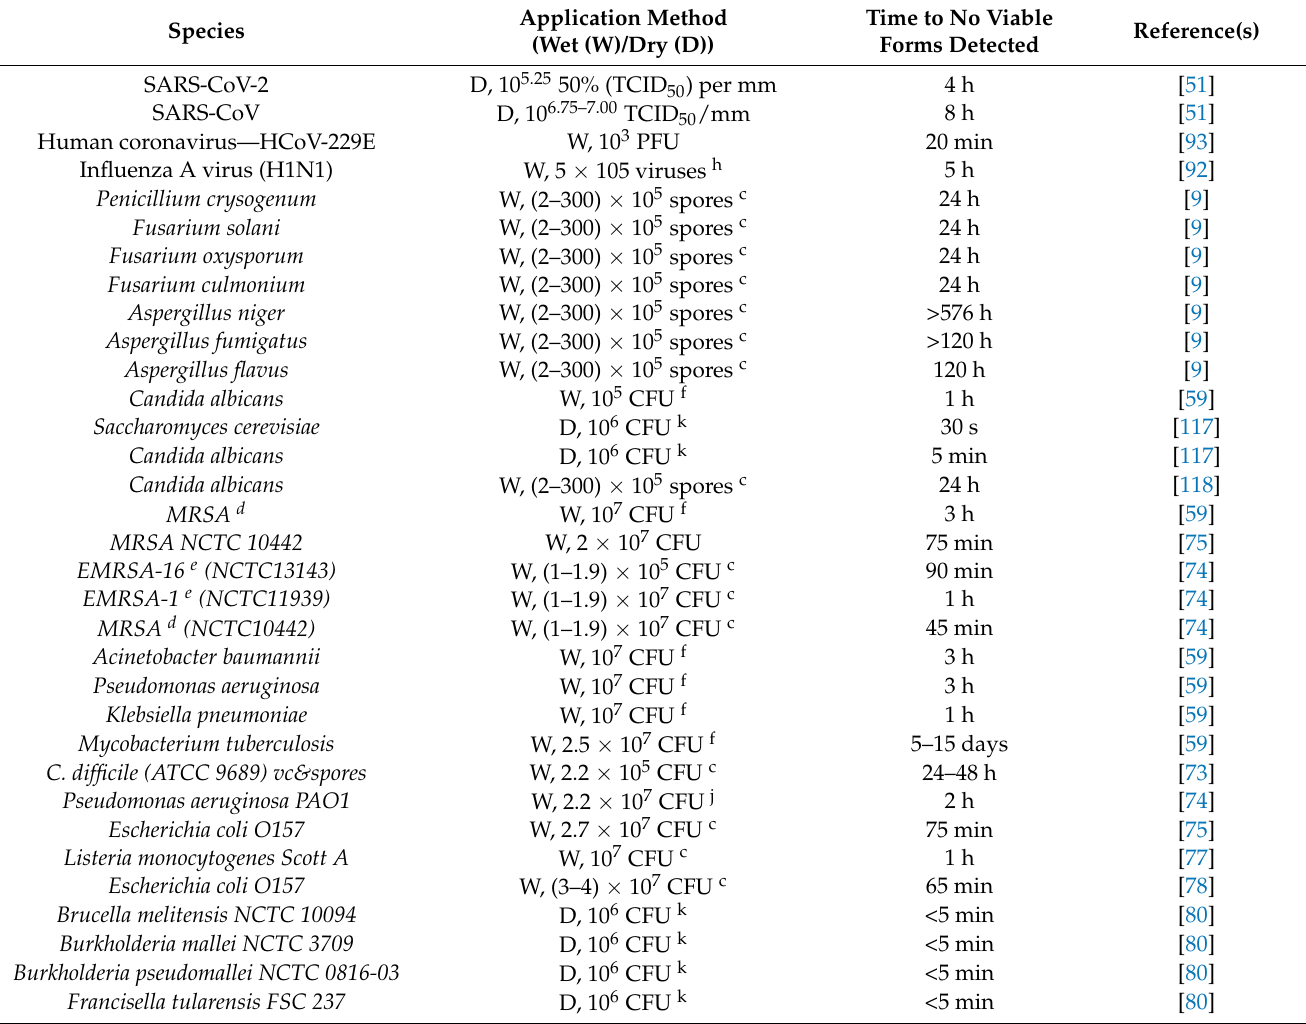
Table 3. Details of contact-killing or inactivation of microbes by copper surfaces. Adapted with permission from Ref. [3]. Copyright 2007, American Society for